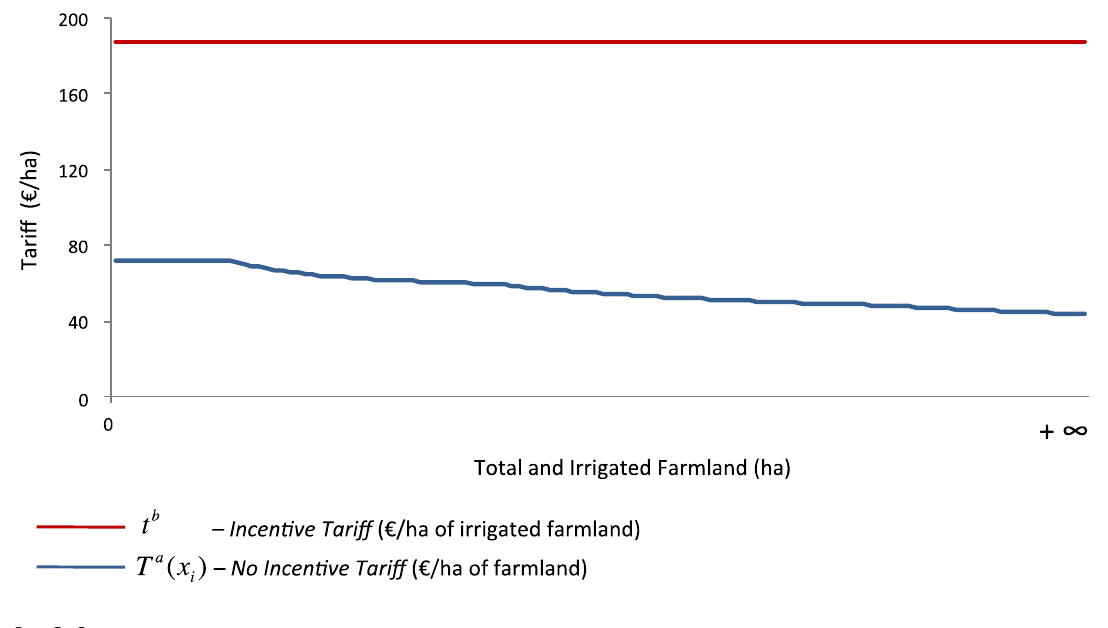
Figure 1. Average tariff trends with increasing total and irrigated farmland for the two tariff